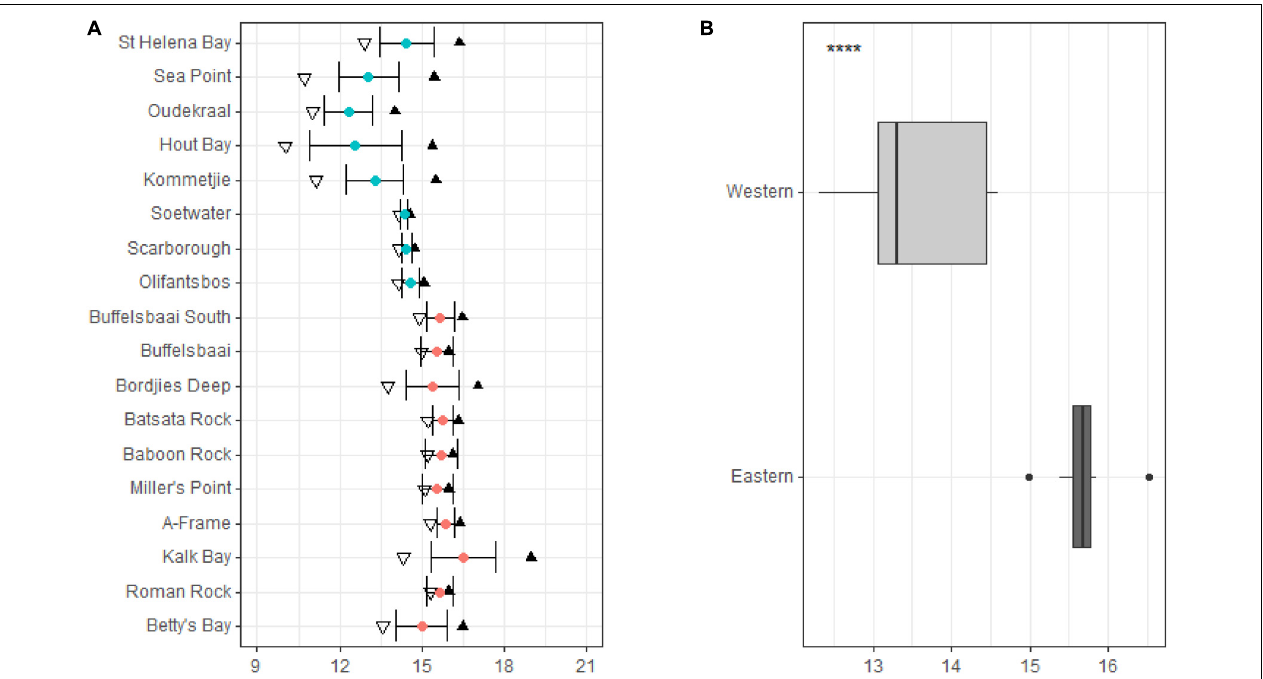
FIGURE 3 | Annual temperature variables at the collection sites around the Cape Peninsula are represented in panel (A) , with sites in order from north to south. Temperature variables include minimum represented by inverted triangles, mean represented by blue and red dots which represent the western and eastern side of the peninsula, respectively, maximum by black triangles, and whiskers standard deviation. Summary of temperature data for sites grouped by region are represented in panel (B) . Significance levels are as follows: * represents ≤ 0.05, ** represents ≤ 0.01, *** represents ≤ 0.001, **** represents ≤